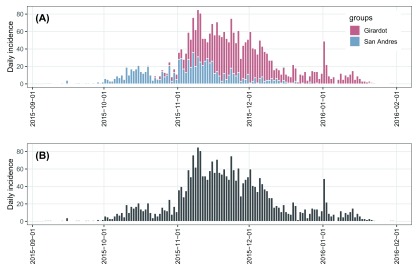
(
A) stratified and (
B) pooled daily incidence plots of ZVD in Colombia, September 2015 to January 2016.